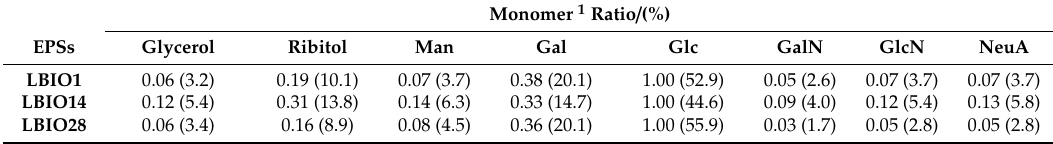
Table 3. Monomer composition, as ratio referred to glucose or as percentage (in brackets), of acetylated methyl glycosides (AMG), after dephosphorylation with aqueous hydrofluoric acid (HF), of EPSs purified from skim-milks fermented for 48 h with the L. plantarum LBIO1, LBIO14 or LBIO28 strains. The Supplementary Figure S3 shows the GC-MS (gas chromatography coupled with mass spectrometry) chromatograms. Monomer 1 Ratio / (%) EPSs Glycerol Ribitol Man Gal Glc GalN GlcN